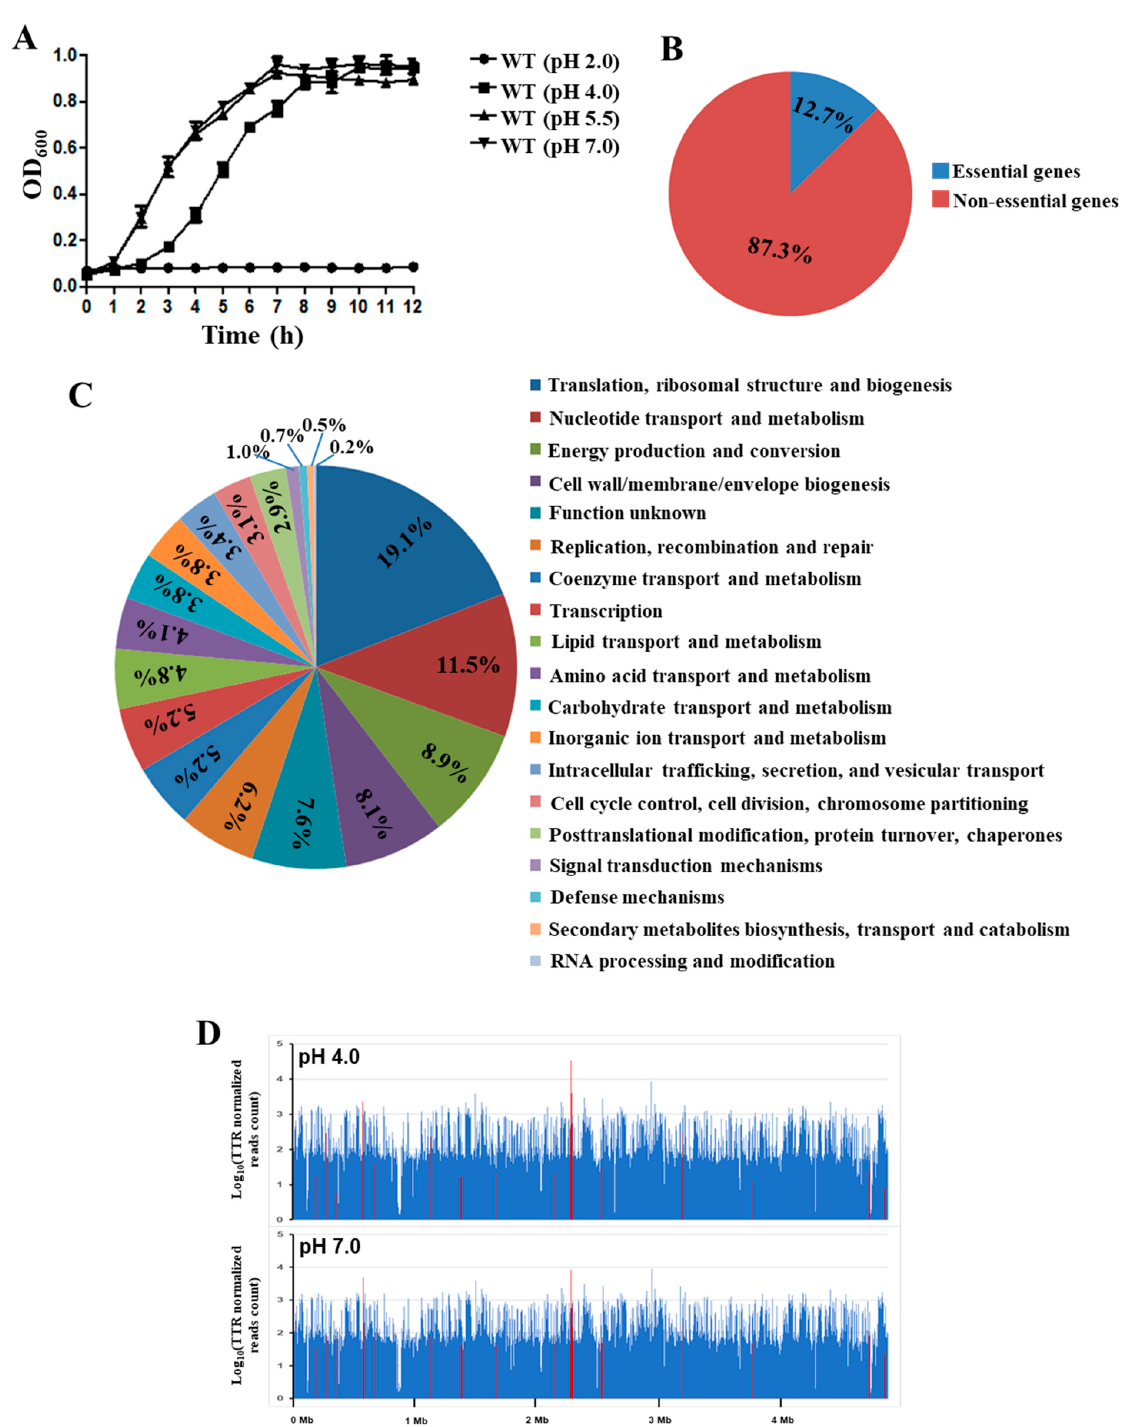
Figure 2. Tn-seq analysis to identify genes involved in acid resistance. ( A ) The growth curves of S . Derby 14T at different pH conditions. The WT was grown in LB medium at pH 2.0, 4.0, 5.5 and 7.0, and the OD 600 values were determined at the indicated time points. The experiments were repeated three times. ( B ) The pie chart of essential genes and non-essential genes as revealed by Tn-seq. ( C ) Functional analysis of essential genes in LB medium at pH 7.0. ( D ) Distribution of the numbers of insertions in the CDS regions across the 14T genome. The upper panel showing the average insertion numbers for each gene of the three replications grown under the pH 7.0 conditions, while the lower panel was those for pH 4.0 acidic conditions. The insertion numbers were shown as Log10 (TTR normalized reads count). Red lines indicate the genes with significantly different insertions, as revealed by the Tn-seq analysis (BH adjusted p -value < 0.05).